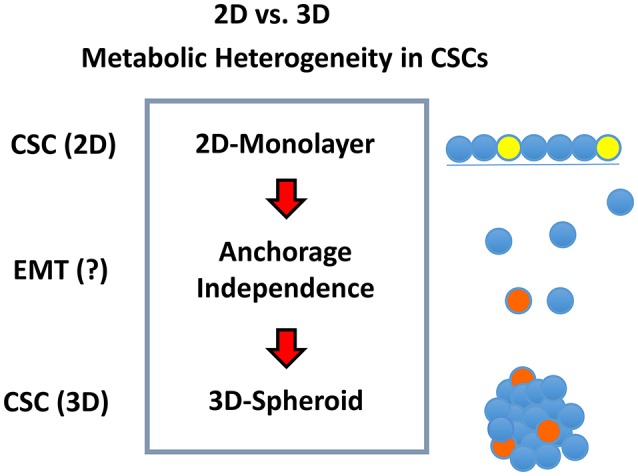
Metabolic heterogeneity in CSCs. We hypothesized that different sub-types or sub-classes of CSCs may exist and that they may differ in their energetic phenotype, based on whether they are physically grown as either 2D-monolayers or 3D-spheroids. We speculated that the transition from a 2D environment to a 3D format would involve an epithelial mesenchymal transition (EMT). Due to the stress of the transition from 2D to 3D growth, it could require additional energy production, possibly afforded by mitochondrial metabolism.